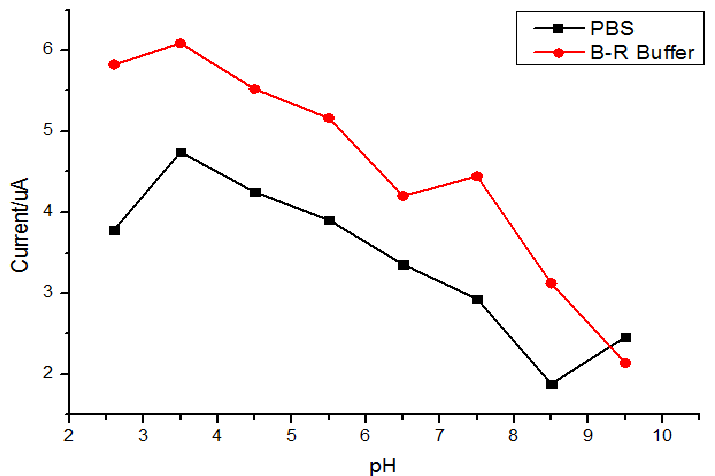
Figure 4. Influence of buffer solution pH by PBS or B-R buffer.